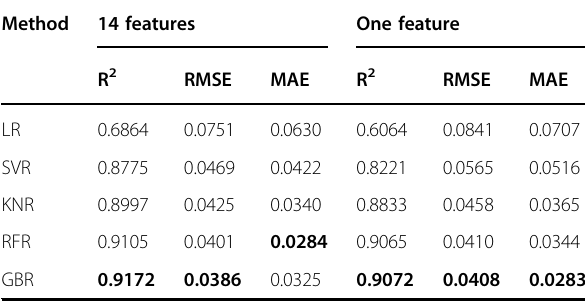
Table 1 The comparison of prediction performance of E g models with different features and ML regression algorithms by three evaluation metrics (R 2 , RMSE and MAE). The best results are highlighted in